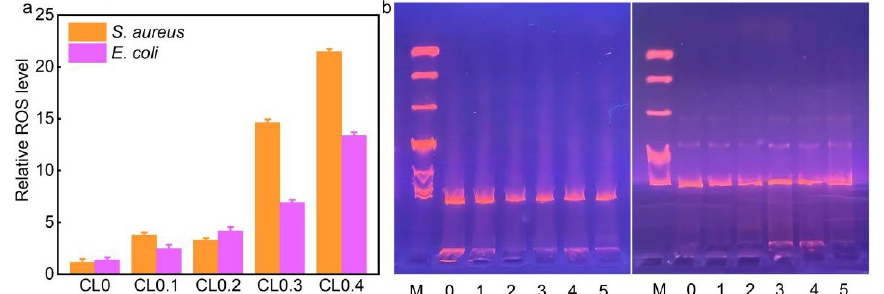
Figure 4. ( a ) Relative ROS levels in S . aureus and E . coli bacteria after incubation with various CLs for 5 h. ( b ) Agarose gel electrophoresis results of the extracted DNA from S . aureus (left panel) or E . coli (right panel) cells treated with PBS (control) or various CLs. M: DNA Ladder DL10000. 0, 1, 2, 3, 4, and 5 represent S . aureus and E . coli treated with PBS (control), CL0, CL0.1, CL0.2, CL0.3, CL0.4, and CL0.5, respectively.